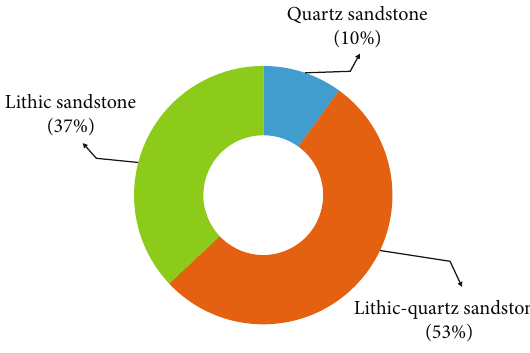
2: Plane porosity of four types of pores in